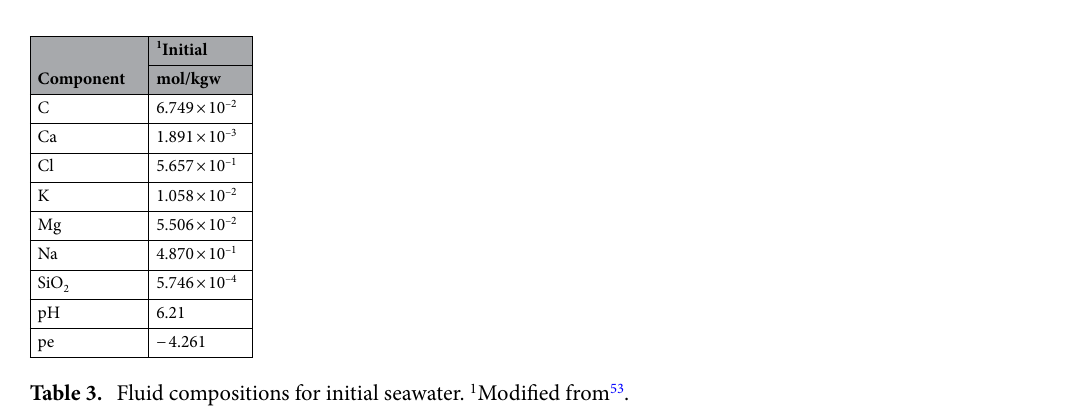
Table 3. Fluid compositions for initial seawater. 1 Modified from 53